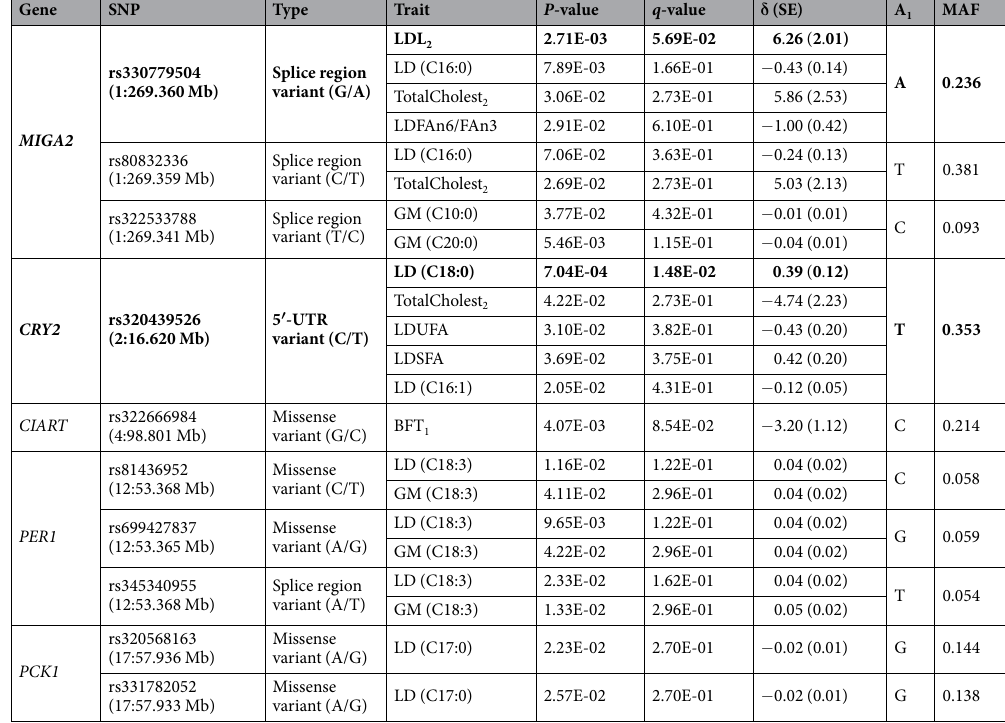
Table 2. Polymorphisms significantly associated with lipid-related traits a . a SNPs in bold show associations that remained significant after correction for multiple testing; q -value: q -value calculated with the false-discovery rate (FDR) method; δ : estimated allele substitution effect and standard error (SE); A 1 : minor allele,